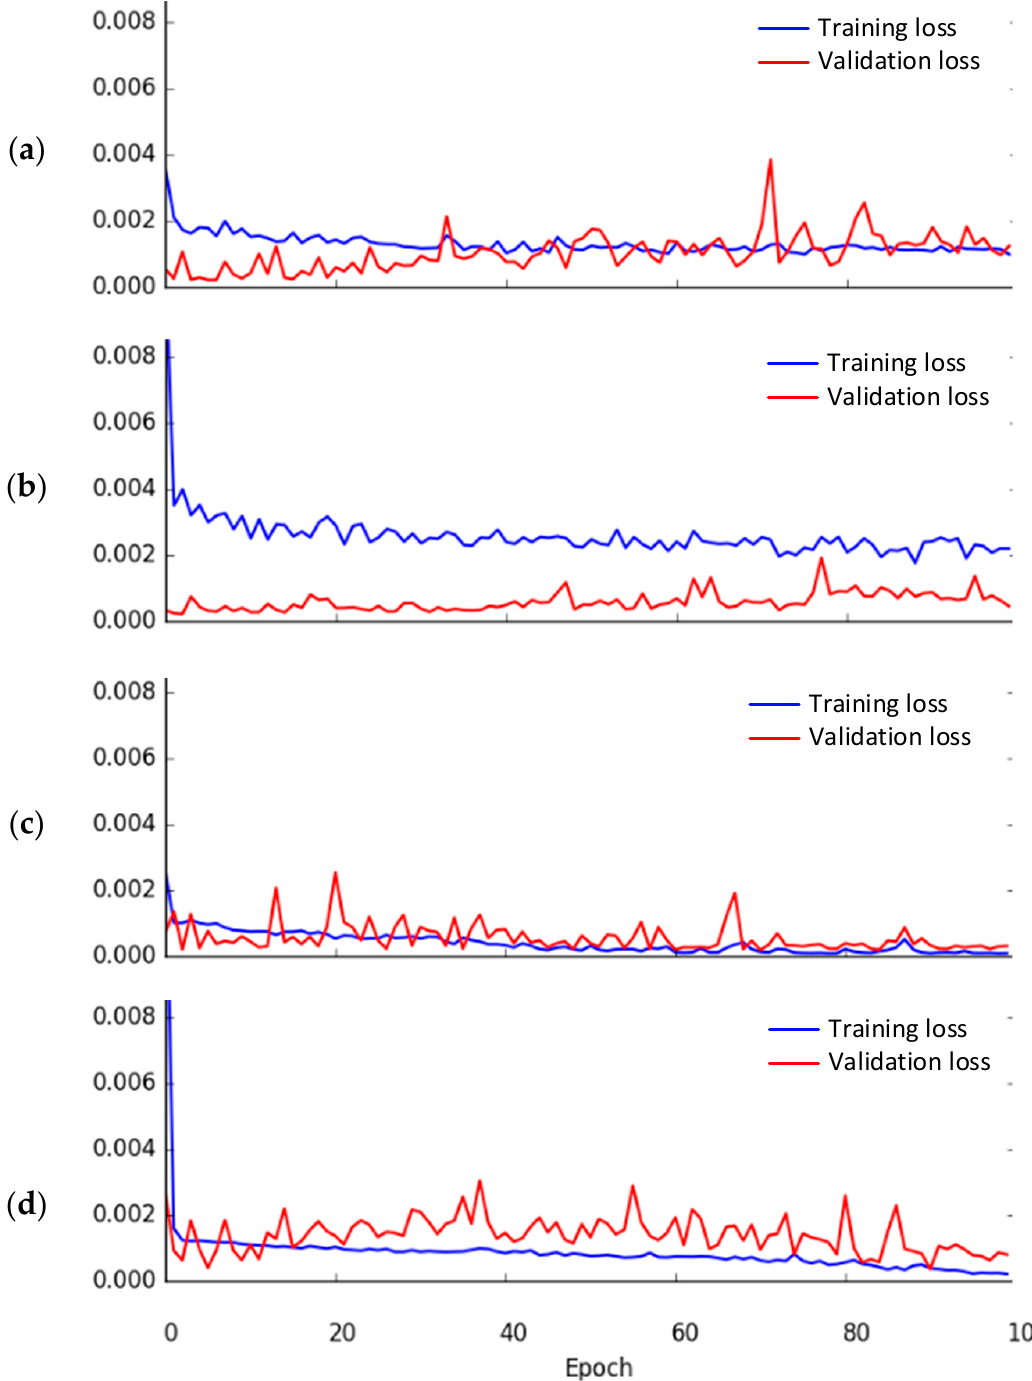
Figure 12. The model loss of RSRP after 8 s of prediction: ( a ) MLP, ( b ) CNN, ( c ) RNN, ( d ) LSTM.